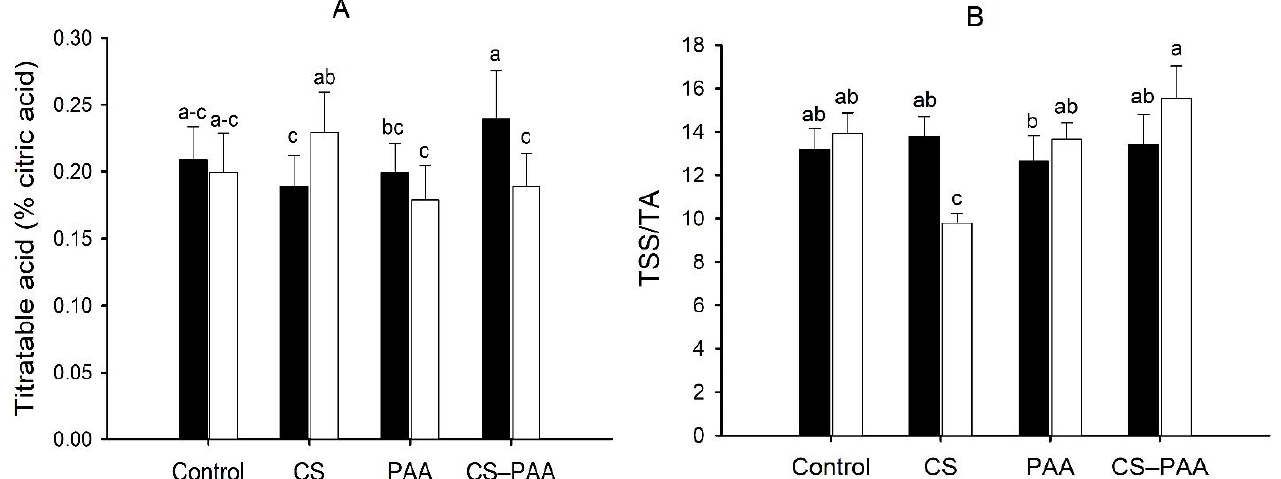
Table 7. Effect of the interaction between nutrient solutions (NSA and NSB; see Table 3) and haba- nero pepper cultivars (Chichen Itza hybrid and Jaguar variety) on total soluble solids (green fruits) and pH (ripe fruits). Figure 3. Effect of the interaction of the foliar applications (Control; CS = chitosan; PAA = poly(acrylic acid); and CS – PAA = chitosan – poly(acrylic acid) complexes) and nutrient solutions (black bars = Nutrient Solution ( A ); white bars = Nutrient Solution ( B )) on titratable acid of the green fruits of the habanero peppers. Lower-case letters different between bars indicate significant difference according to Fisher’s LSD test ( p ≤ 0.05).